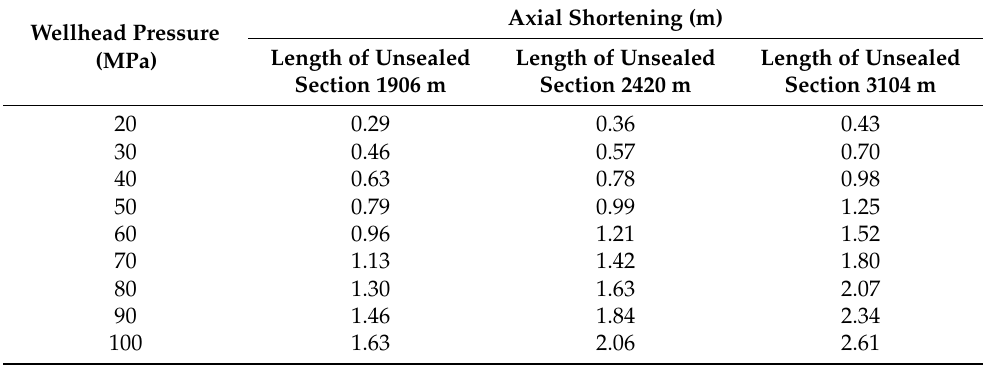
Figure 1. Structure of horizontal well A. Table 1. Axial shortening of casing under different length of unsealed section.